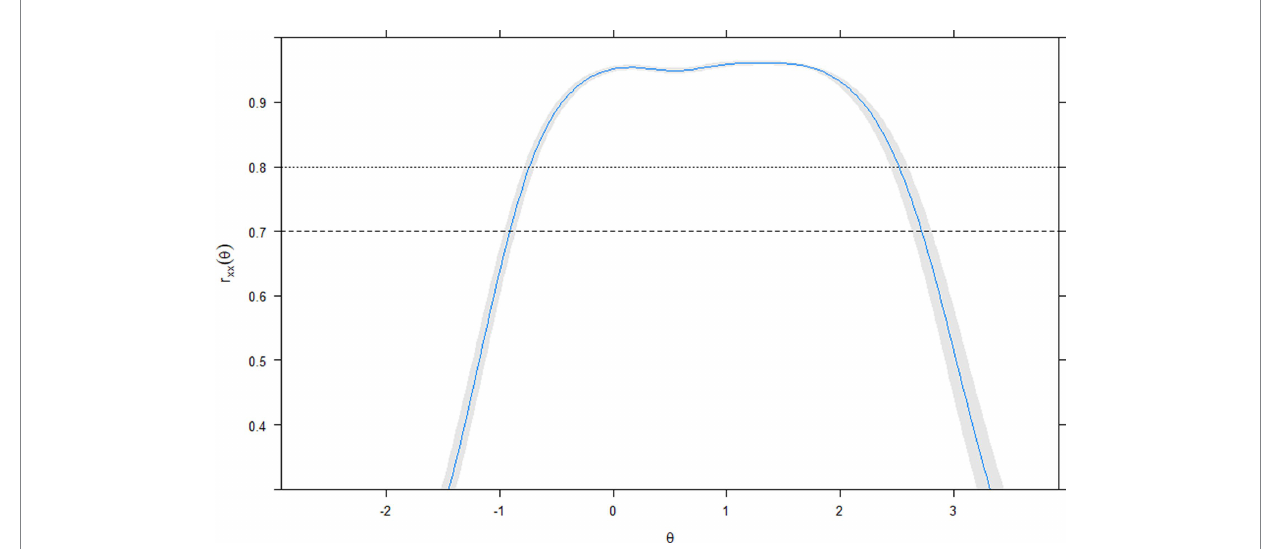
FIGURE 5 Conditional reliability of GAD-7 latent construct. r xx ( θ ): empirical reliability. θ : latent trait.